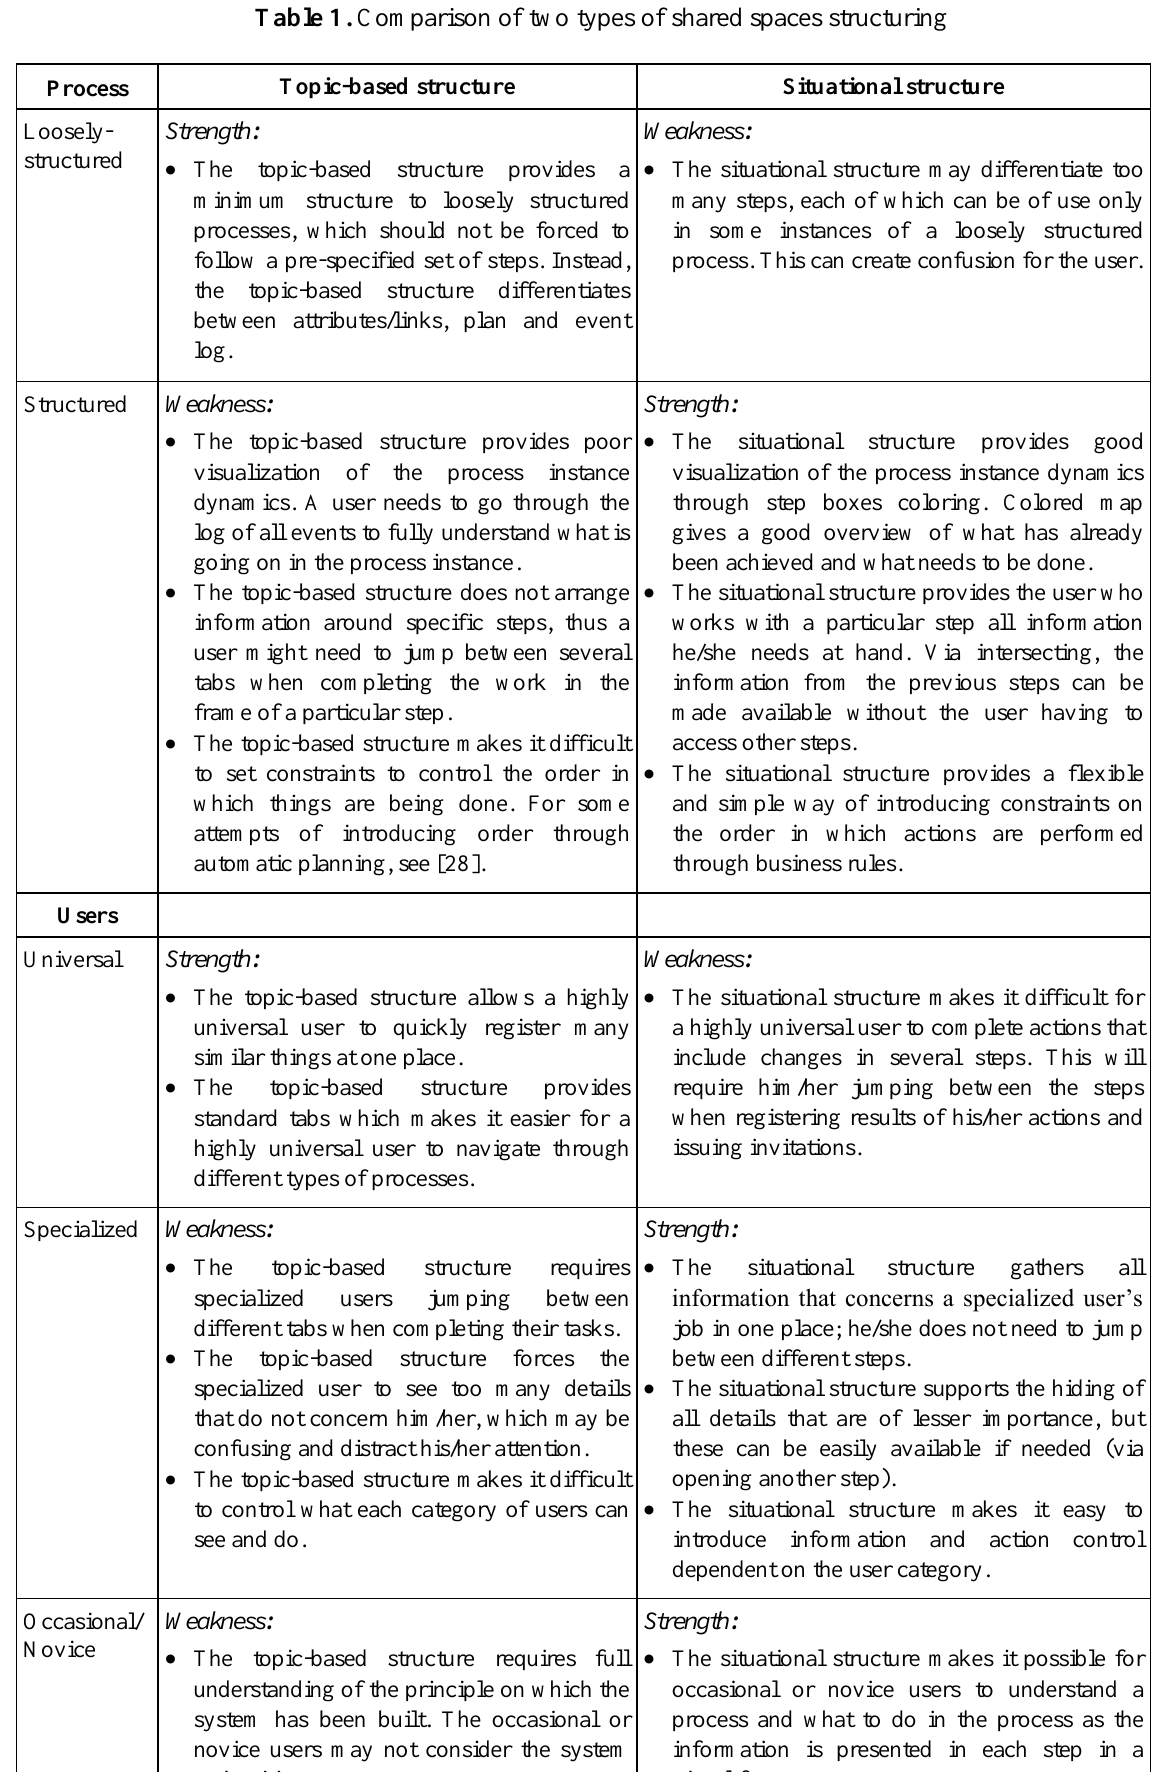
Table 1. Comparison of two types of shared spaces